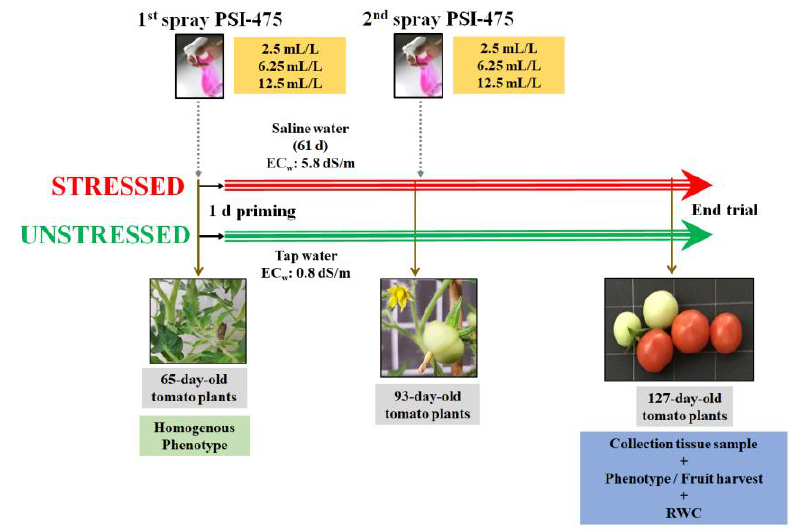
Figure 8. Graphical representation of tomato plant trials using a 61 day-saline irrigation water program to evaluate the bioactivity of PSI-475.